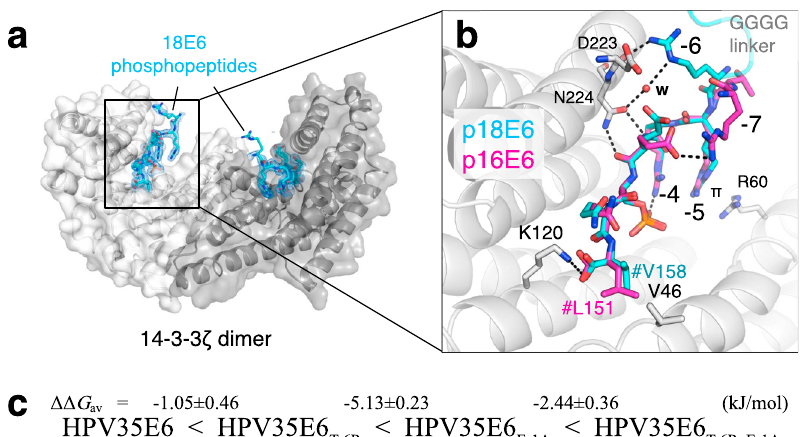
Fig. 2 Structural basis for the 14-3-3 ζ /phospho-18E6 PBM interaction. a An overall view on the 14-3-3 ζ dimer (subunits are in tints of gray) with two bound 18E6 phosphopeptides (cyan sticks, shown with the 2Fo-Fc electron density maps contoured at 1 σ ). b An overlay of the two 14-3-3 bound phosphopeptides from 16E6 (PDB ID: 6TWZ; magenta sticks) and 18E6 (this work; cyan sticks) showing the similarity of the conformation. # denotes the C-terminus (-COOH). w — water molecule, π — π -stacking interaction. Key positions are numbered according to the PBM convention. c Averaged ΔΔ G values between 14-3-3 isoforms and 35E6 phospho-PBM pairs, calculated based on their observed order of binding af fi nities (from weakest to strongest). Individual K D values from Supplementary Fig. 2 were fi rst converted into Δ G values (at T = 295 K; excluding cases when K D > 300 μ M), then average ΔΔ G values ( ΔΔ G av ) were calculated between the indicated HPV35E6 motifs.